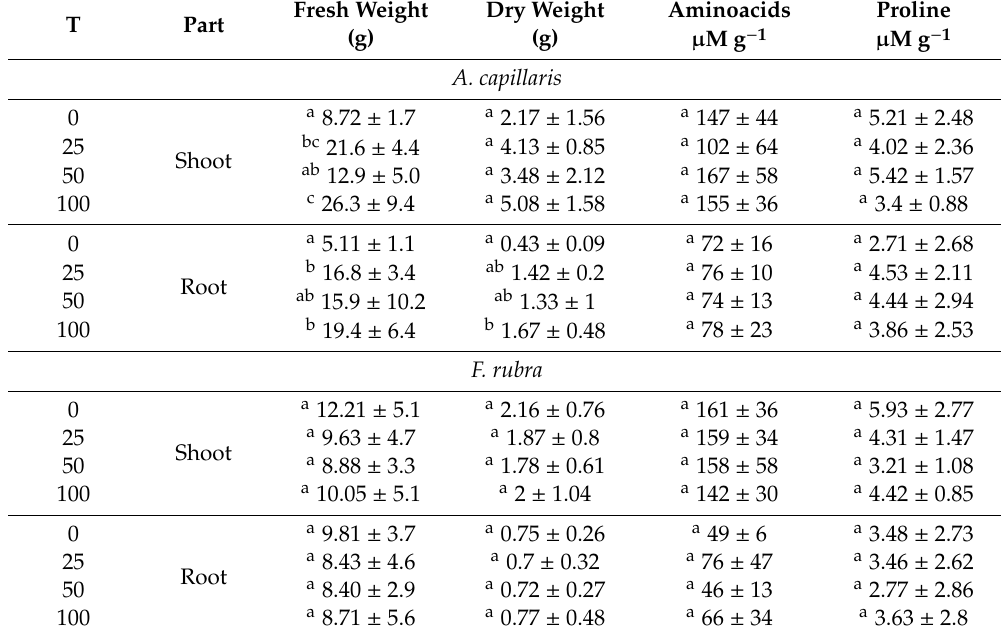
Table 3. Plant characteristics at the end of the hydroponic experiment. Treatment (T) expresses mg of nZVI per L of hydroponic solution. ANOVA was performed for shoot and root separately. Di ff